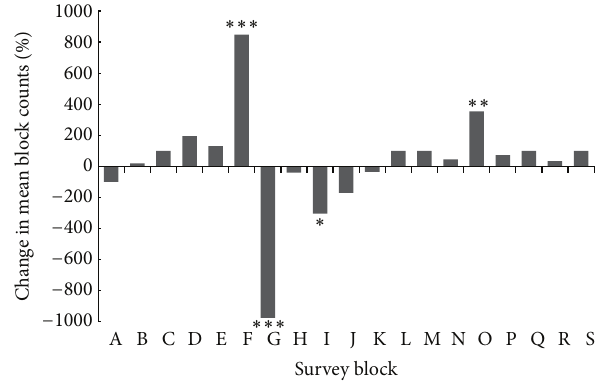
Figure 5: Percent change in mean lemon shark block counts (unit effort; UE) from high tide to low (positive) and low to high (negative) tide surveys; 𝜒 2 significant 𝑃 values denoted by ∗ 𝑃 < 0.05 , ∗∗ 𝑃 < 0.01 , ∗∗∗ 𝑃 < 0.001